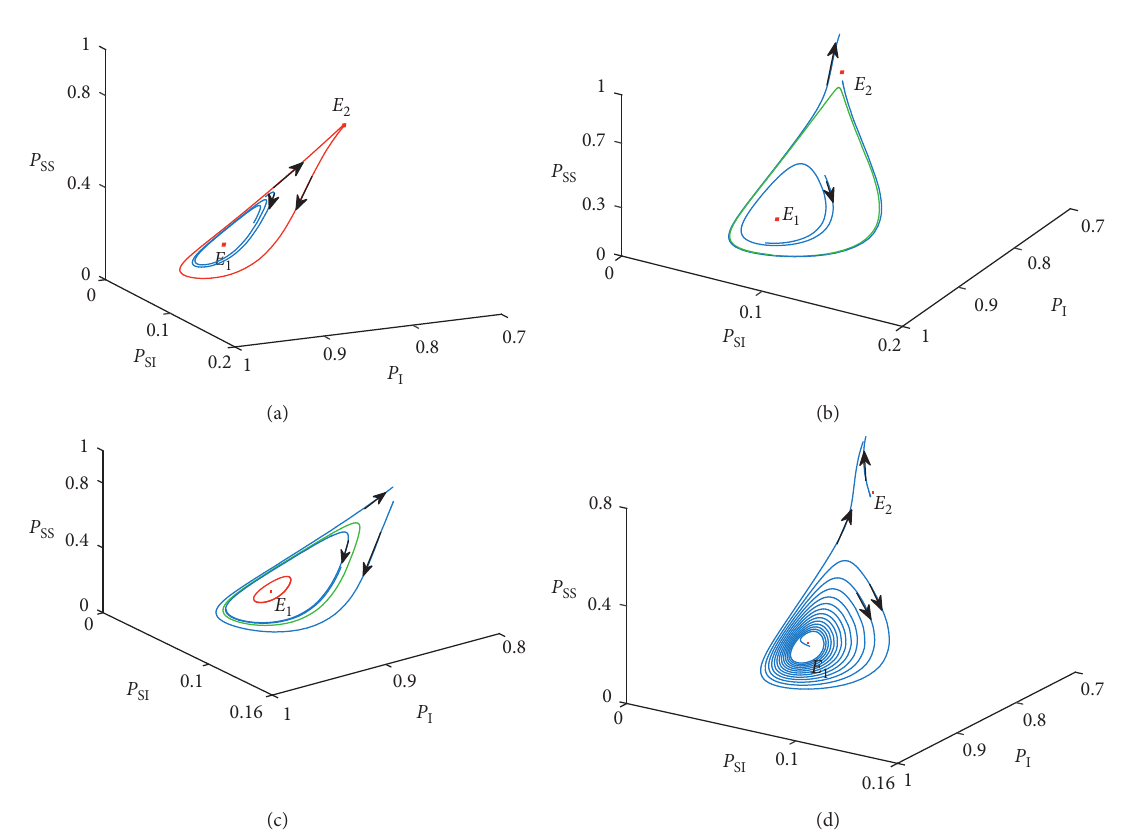
Figure 3: Global dynamics of system (5), where τ � 0 . 5 , n � 6 , ω � 2 . 9 , and c � 0 . 13. (a) Coexistence of a homoclinic orbit with a stable equilibrium in region II, where β � 7 . 89. (b) Coexistence of an unstable cycle with a stable equilibrium in region II, where β � 7 . 91. (c) Coexistence of an unstable cycle with a stable cycle in region III, where β � 7 . 99. (d) E free equilibrium in region III, where β � 8 . 1.